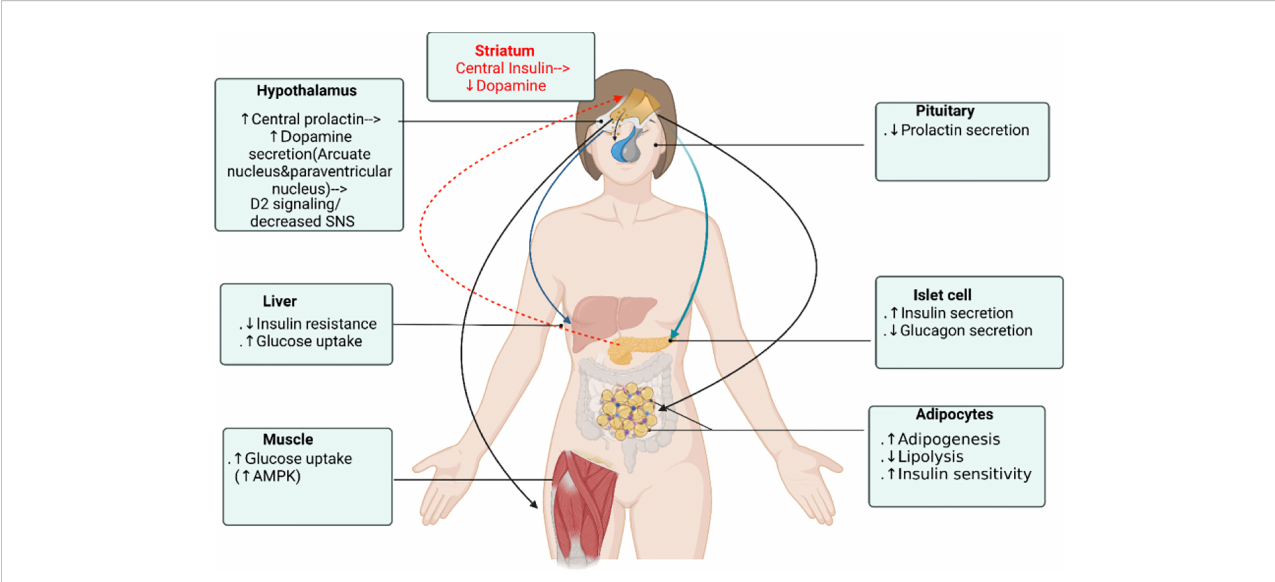
FIGURE 1 Dopamine receptor agonist glucose-lowering actions on different organs. Dopamine agonists affect glucose homeostasis by 1) stimulating central prolactin that increase ventral medial and arcuate hypothalamic dopamine that act through 2) dopaminergic/decreased sympathetic activity signaling which 3) directly act on islet to stimulate insulin secretion and on adipocyte, hepatocyte, skeletal muscle D2R to modulate their metabolic effects, not by the serum prolactin level. Reciprocally, central insulin suppresses dopamine level in the ventral striatum and mesolimbic dopamine system. Figure created using BioRender